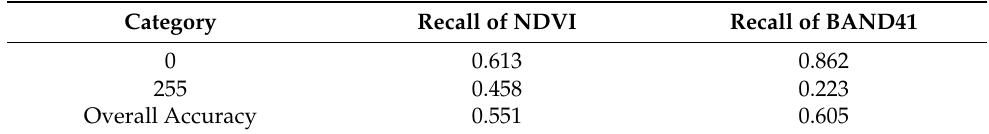
Table 11. Quantitative comparison results of vegetation extraction from the Washington DC Mall data